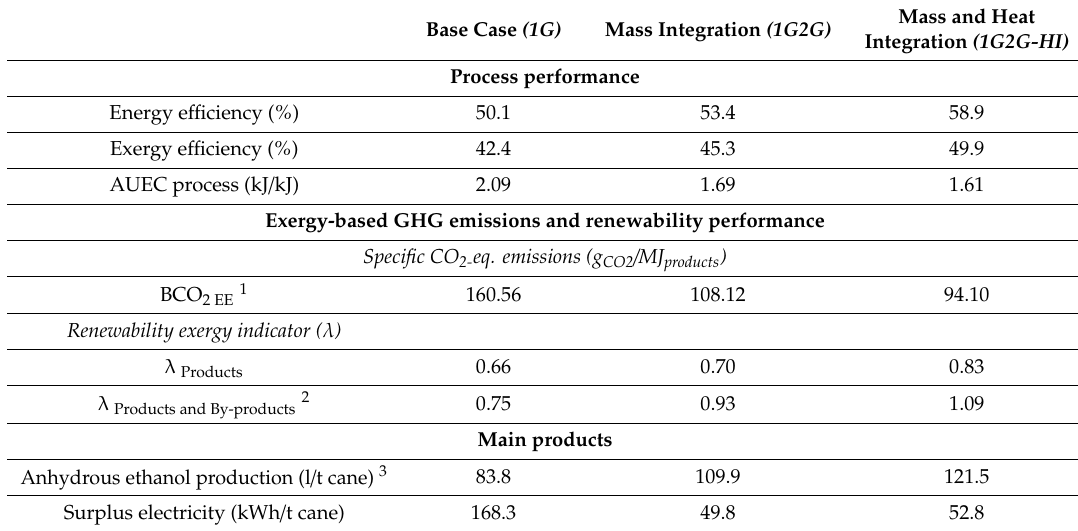
Table 3. Key performance indicator (KPI) results for the ethanol processes